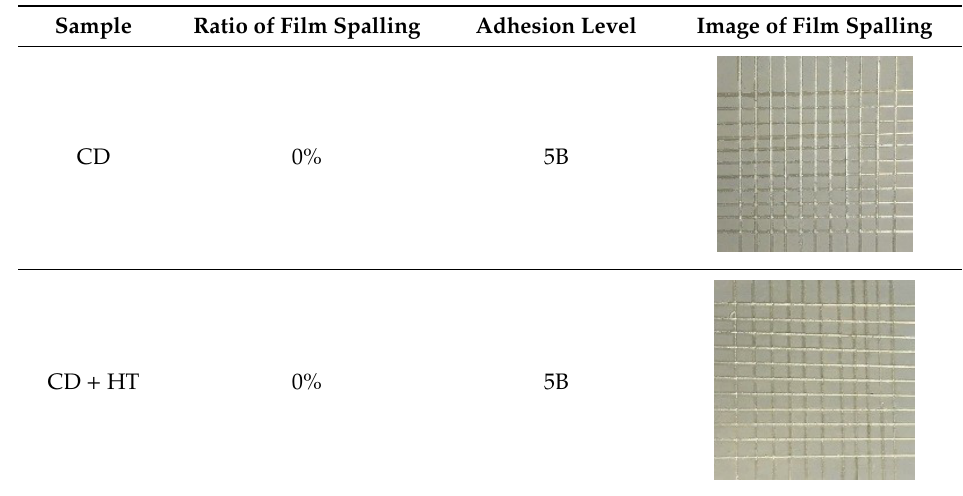
Table 5. Adhesion test results of typical samples.